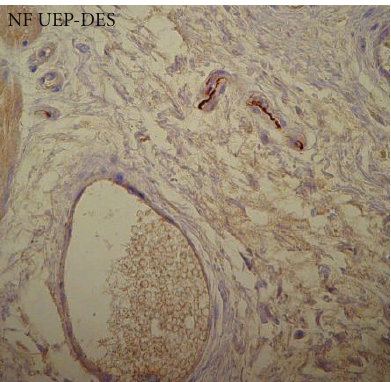
Figure 3: Neurofilament (NF). A di ff use weak immunostaining expression is obvious at myoenteric site of both atretic esophageal segments. In some cases the NF immunoreactivity is absent in the